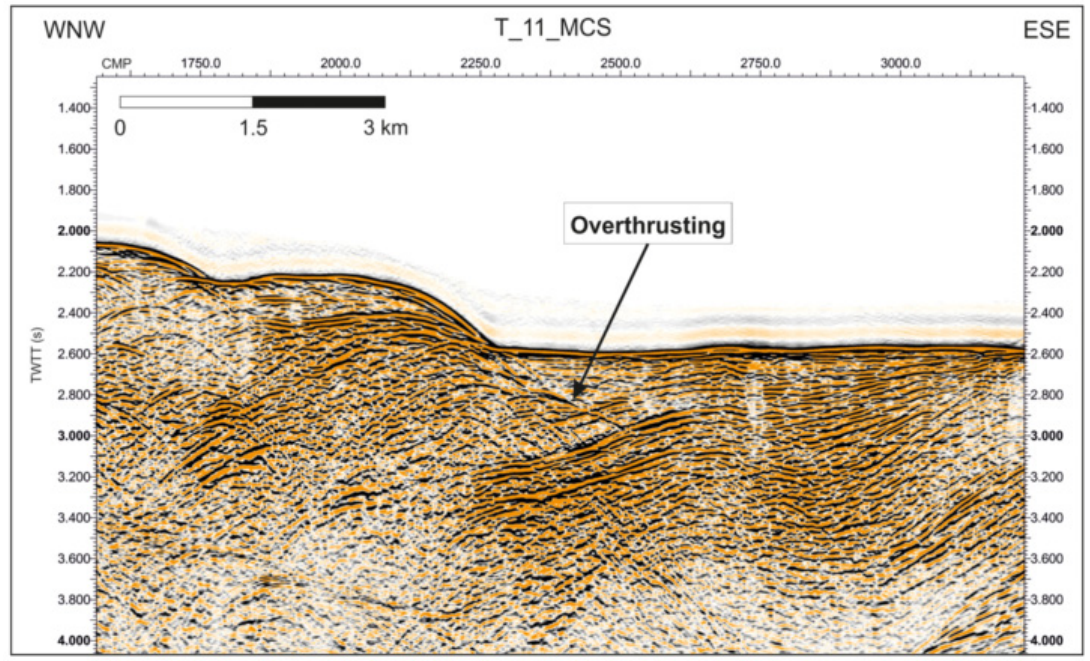
Figure 16. Part of a migrated stack of the T_11_MCS line (Ionian Sea, see Figure 2 for line location). See text for further details.